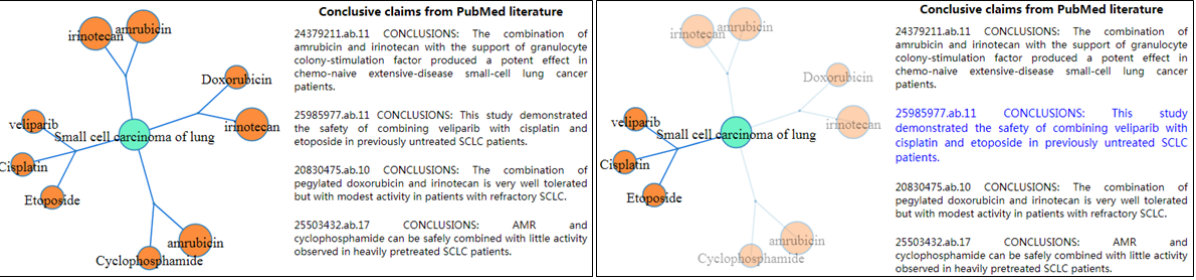
Figure 2. Customized knowledge graph visualization (left) and the conclusive claim being highlighted